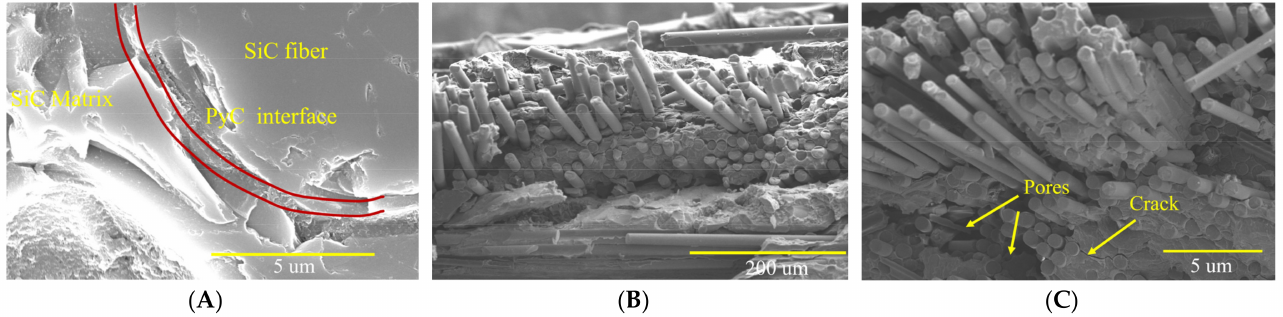
Figure 9. SEM images of the SiC f /PyC/SiC composites. ( A ) Interface, ( B ) fracture morphology, and ( C ) fiber pulling